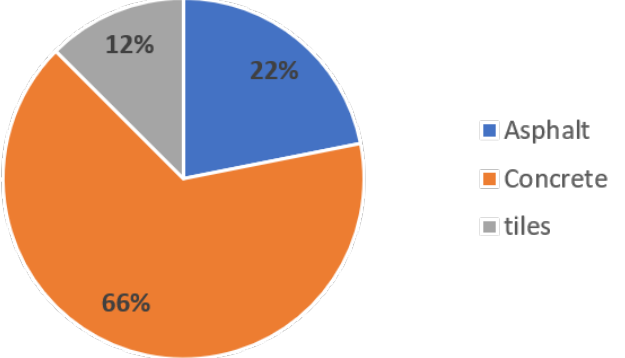
Figure 5. The most comfortable surface to move on according to wheelchair